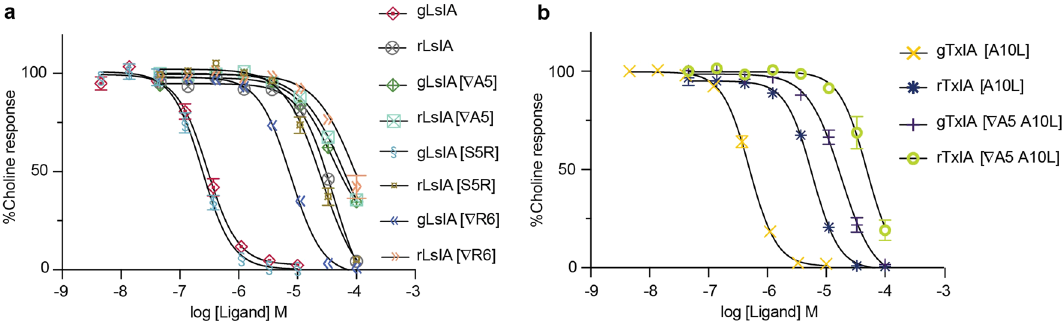
Figure 6. Functional characterisation of LsIA ( a ), TxIA [A10L] ( b ) and their analogues at human α7-containing nAChRs. Concentration response curves for LsIA, TxIA [A10L] and their analogues at α7-containing nAChRs on SH-SY5Y cells are shown. Data represent mean ± SEM of triplicate data from three independent experiments.